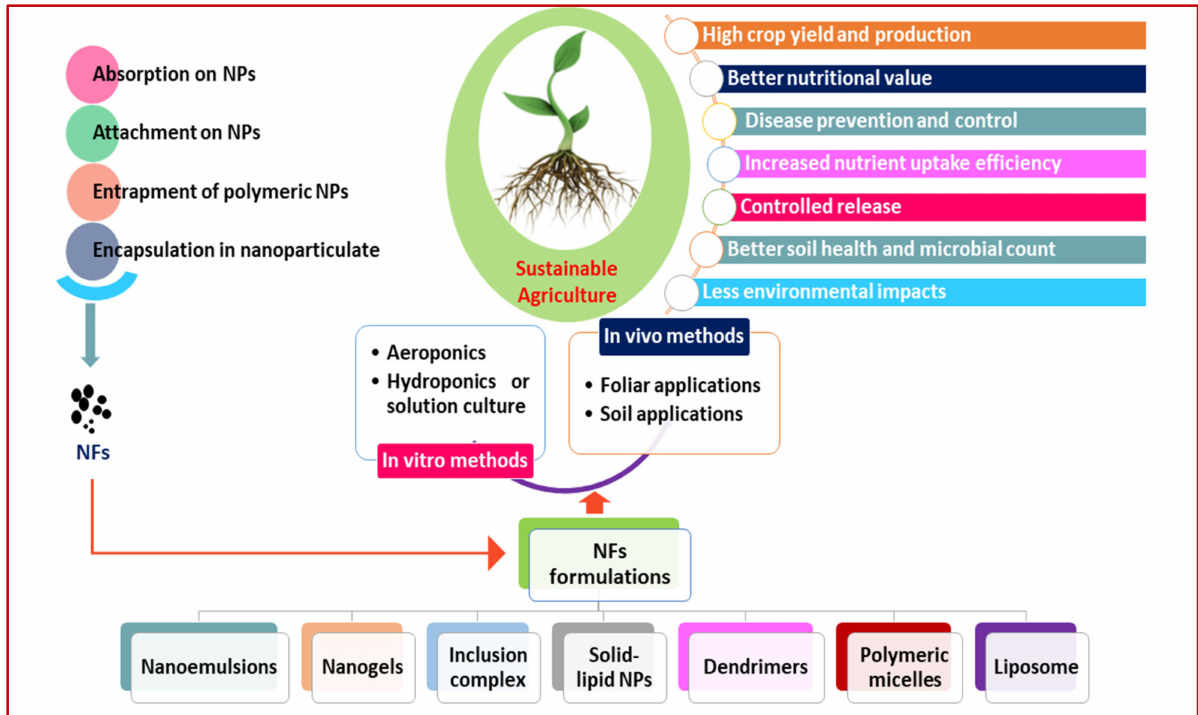
Figure 1. An overview of nano-fertilizer application in agriculture. NPs = nano-particles; NFs =